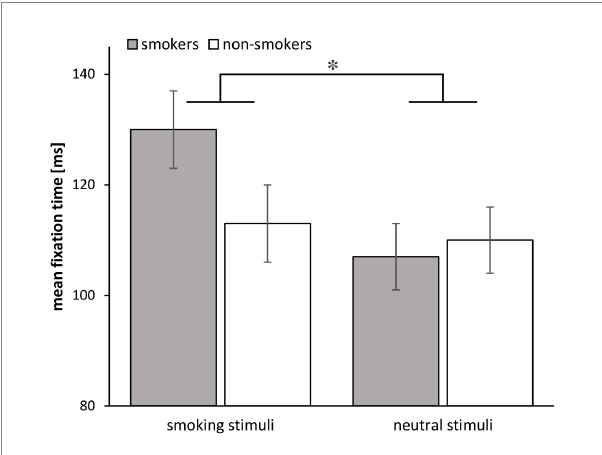
FIGURE 5 Mean fixation times for smokers ( n = 34) and non-smokers ( n = 37) in the free-viewing task. The asterisk indicates the significant interaction. Error bars show standard errors.